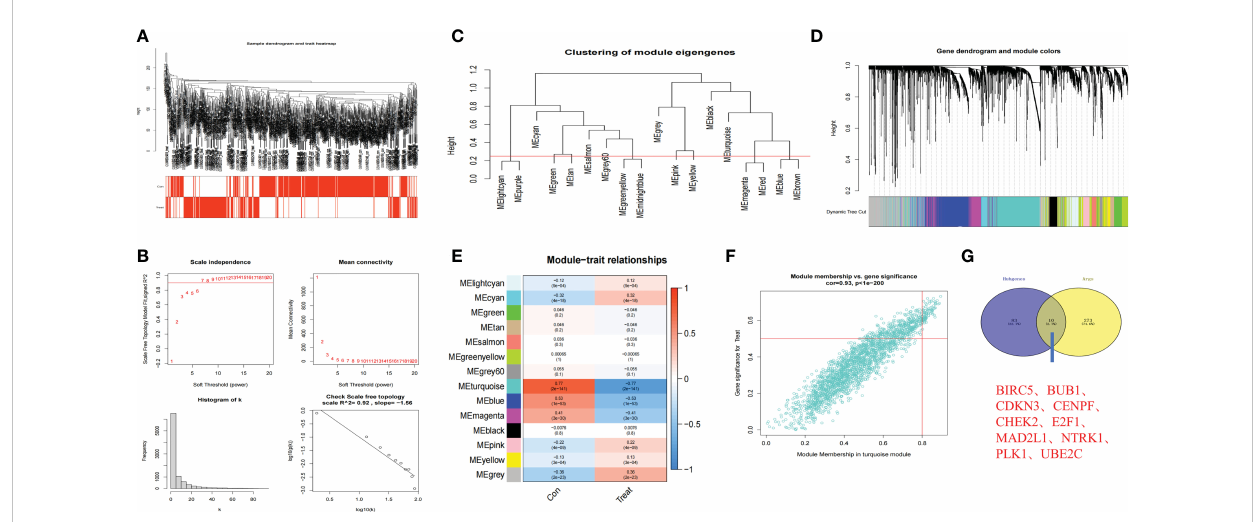
FIGURE 4 Hub genes in anoikis-related subtypes based on WGCNA. (A) Clustering dendrogram of 721 samples. (B) Construction of scale-free network (Soft threshold value=7, R 2 = 0.92). (C, D) . 18 anoikis-related modules of NB were screened and further combined into 14 modules (Red line in C: MEDissThres = 0.25). (E) Relationships between anoikis and 14 modules. Turquoise module was most closely related to anoikis in NB. (F) Scatterplot analysis of Turquoise module. Key genes were fi ltered in the upper right region of GS > 0.5 and MM > 0.8. (G) The Venn plot of 10 hub genes in Turquoise module and 283